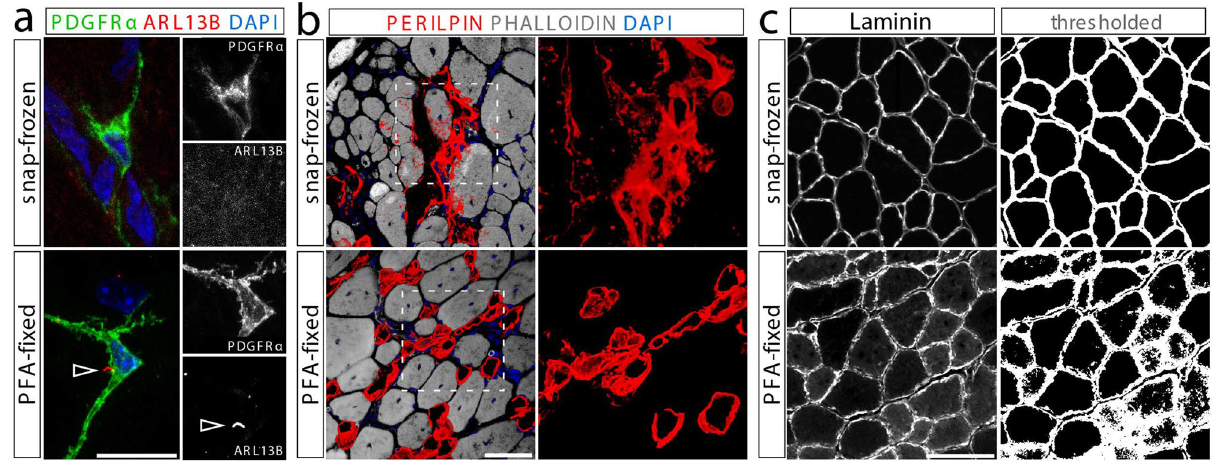
Figure 1. Fixation of muscle tissues is required to preserve certain cellular structures. ( a ) Cilia, marked by ARL13B (red), can only be detected on FAPs, labeled by PDGFR α (green), in PFA-fixed (bottom) but not snap- frozen (top) tibialis anterior muscle sections. Scale bar is 10 μm. ( b ) The morphology of PERILIPIN-expressing adipocytes (red) is severely compromised without prior fixation. Scale bar is 50 μm. ( c ) Laminin (gray) perfectly outlines myofibers in snap-frozen tissue (top) enabling simple myofiber segmentation using ImageJ thresholding. However, fixation impacts Laminin immunoreactivity preventing myofiber segmentation. Scale bar is 250